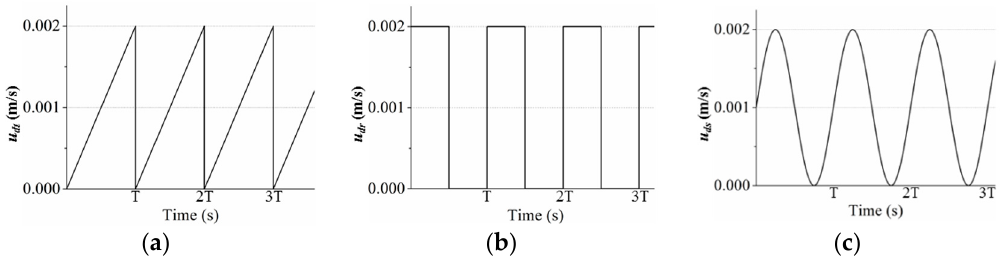
Figure 5. Dynamic dispersed injection flow rate of different types. ( a ) Triangle wave dynamic injection flow rate ( u dt ); ( b ) Rectangular wave dynamic injection flow rate ( u dr ); ( c ) Sine wave dynamic injection flow rate ( u ds ).